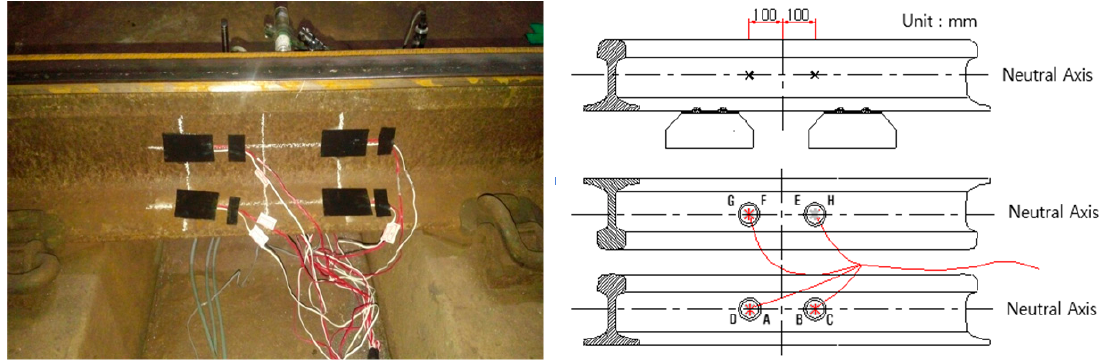
Figure 5. Strain gauge installation.